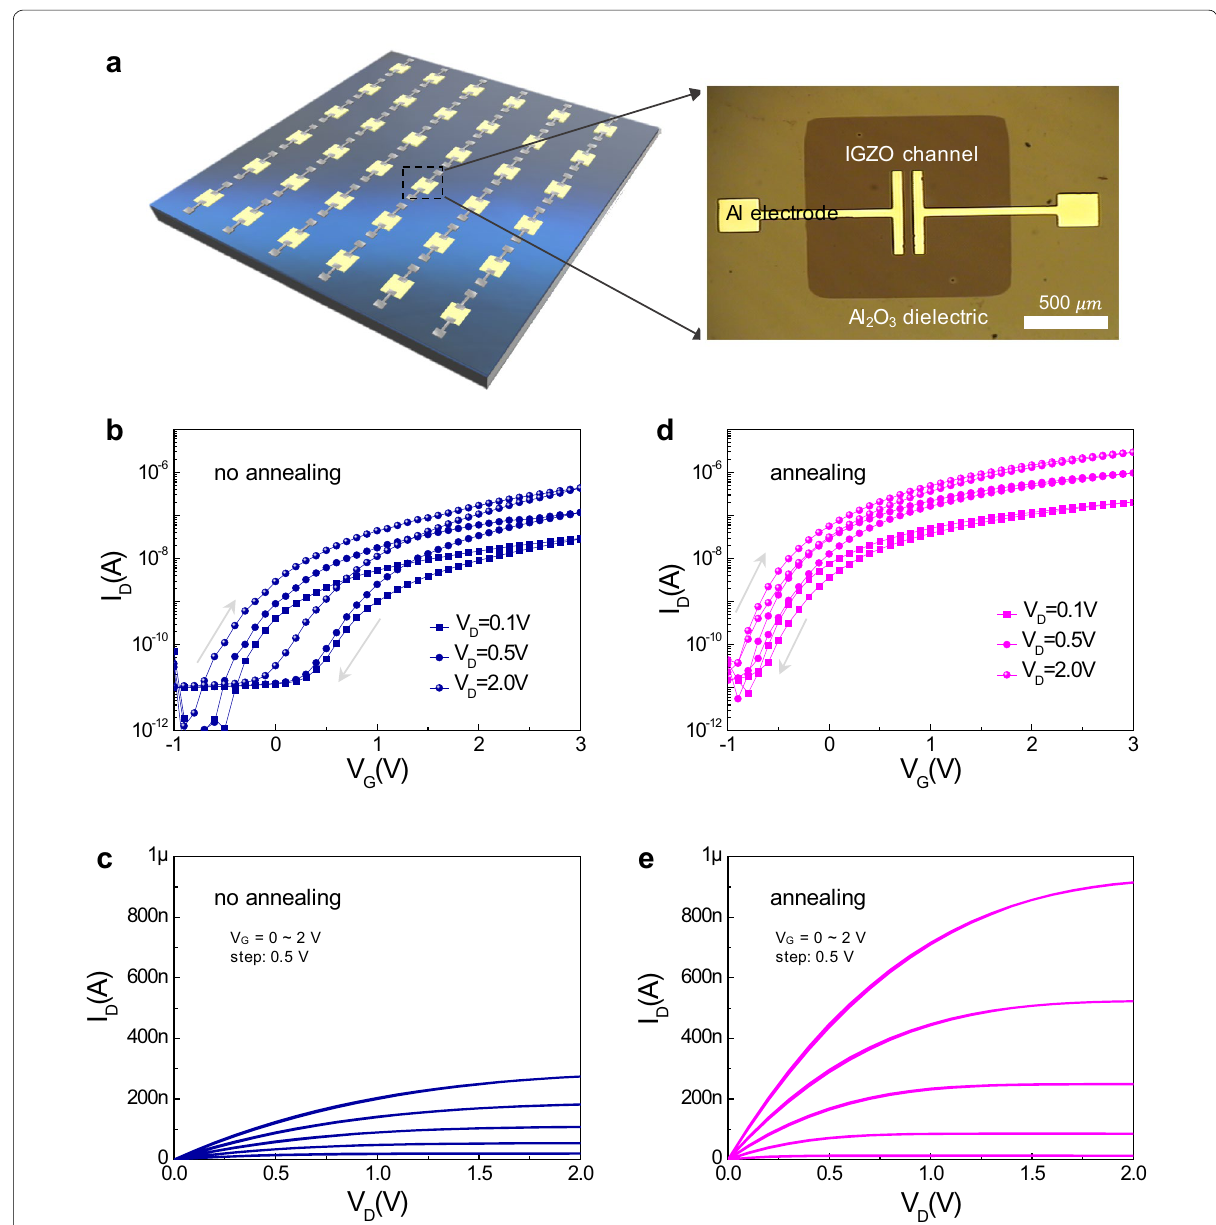
Fig. 1 a Schematic of IGZO transistor array devices. The inset shows an optical microscope image of a single IGZO device with a channel region (50 μm length and 500 μm width). Transfer characteristics (drain current–gate voltage of I D –V G ) of b reference IGZO transistor without post‑annealing and d IGZO transistor with post‑annealing at variable V D (0.1, 0.5, and 2 V). Output characteristics (I D –V D ) of c reference IGZO transistor and e IGZO transistor with post‑annealing at variable V G from 0 to 2